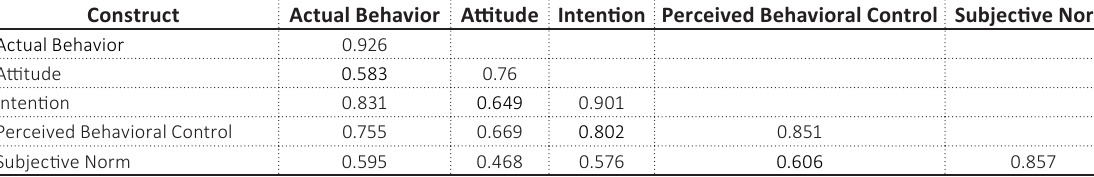
Table 3. Discriminant validity